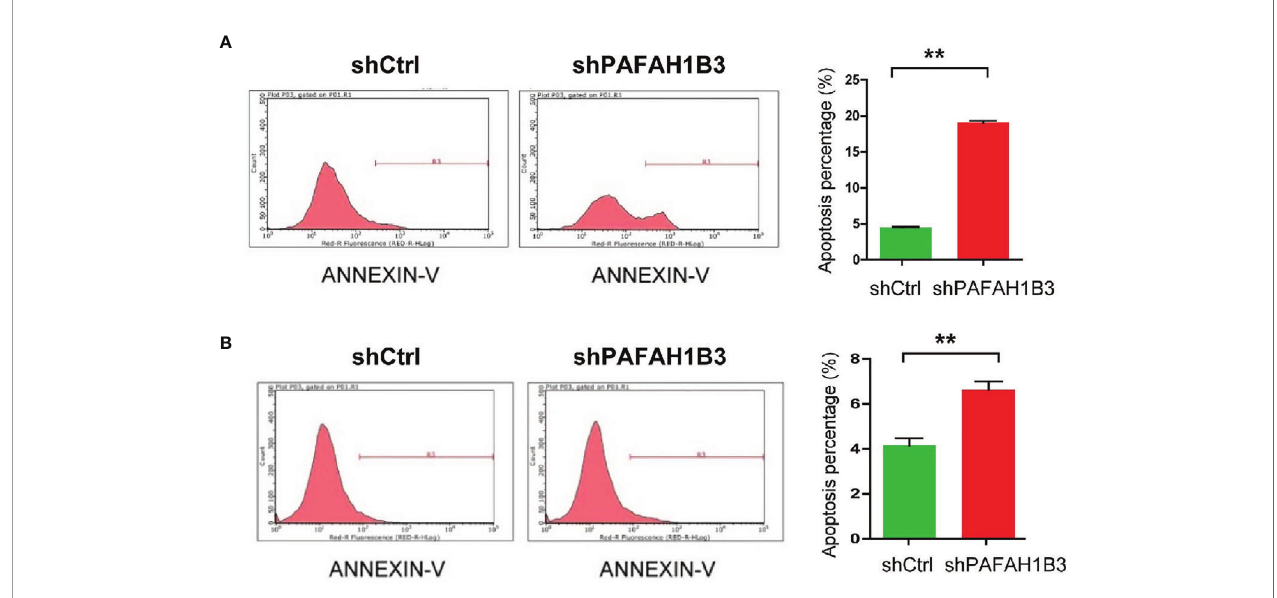
FIGURE 4 | PAFAH1B3 knockdown promoted apoptosis in osteosarcoma cells. (A) The proportion of apoptotic cells in MNNG/HOS cell line was signi fi cantly increased in PAFAH1B3 knockdown group assessed by fl ow cytometry. Data were expressed as the mean ± s.d., ** P < 0.01. (A, B) The proportion of apoptotic cells in U-2 OS cell line was signi fi cantly increased in PAFAH1B3 knockdown group assessed by fl ow cytometry. Data were expressed as the mean ± s.d., ** P <